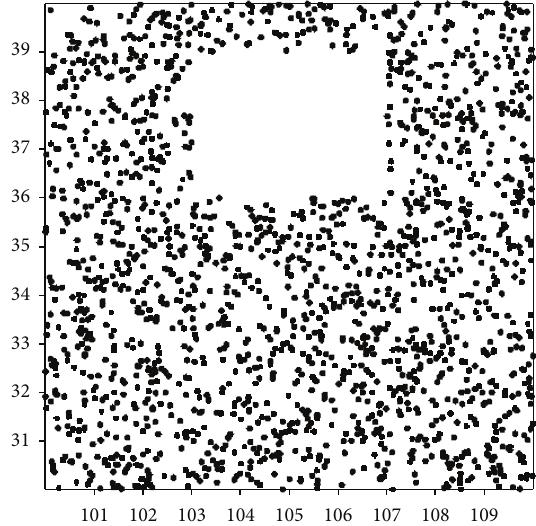
and land surface temperature (LST), respectively. Wu et al.